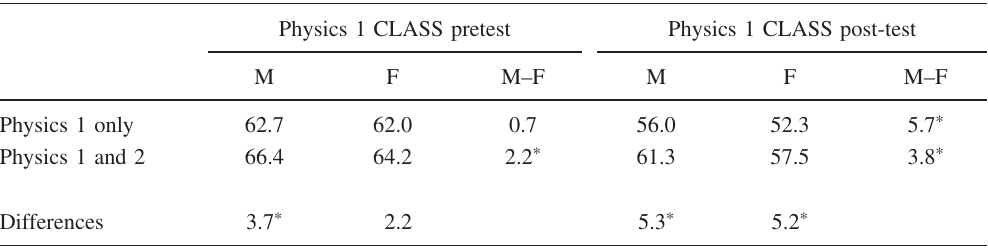
TABLE IV. Gender gaps in Physics 1 CLASS (cid:1) % favorable (cid:2) pretest, post-test, and shifts for those students who took Physics 1 but then did and did not take Physics 2. The differences in the bottom row are (cid:1) Physics 1 and 2 – Physics 1 only (cid:2) . The asterisk (cid:1) (cid:1) (cid:2) indicates that the difference is significant at the p (cid:1) 0.05